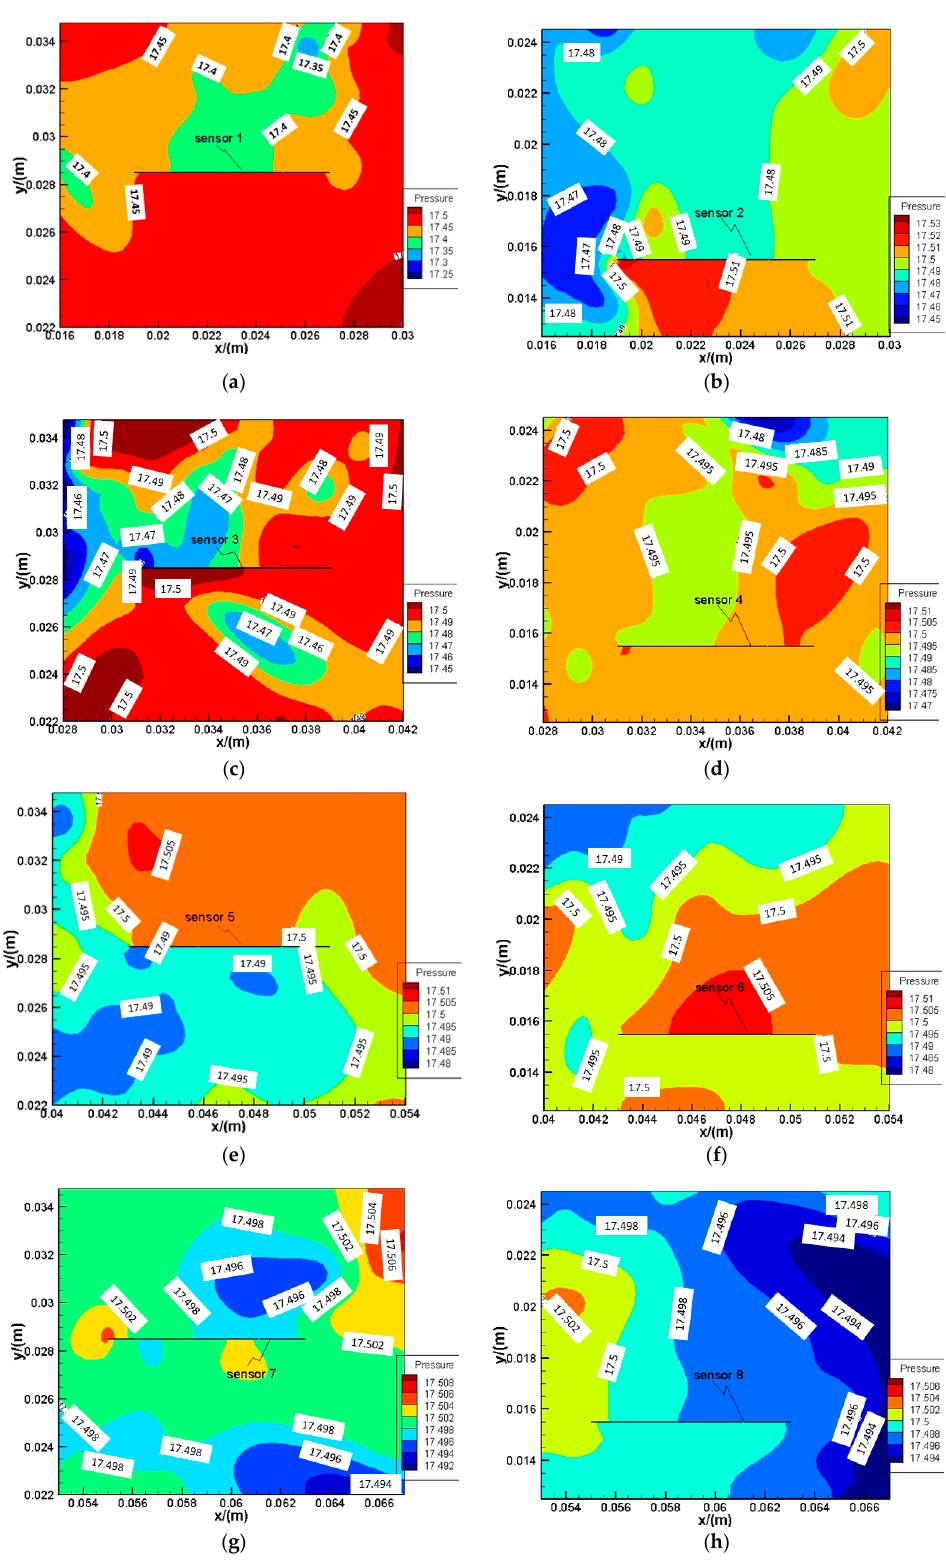
Figure 13. Contours of the static pressure distribution near each sensor on section z = 0 at 1s. ( a ) Sensor 1; ( b ) Sensor 2; ( c ) Sensor 3; ( d ) Sensor 4; ( e ) Sensor 5; ( f ) Sensor 6; ( g ) Sensor 7; ( h ) Sensor 8.